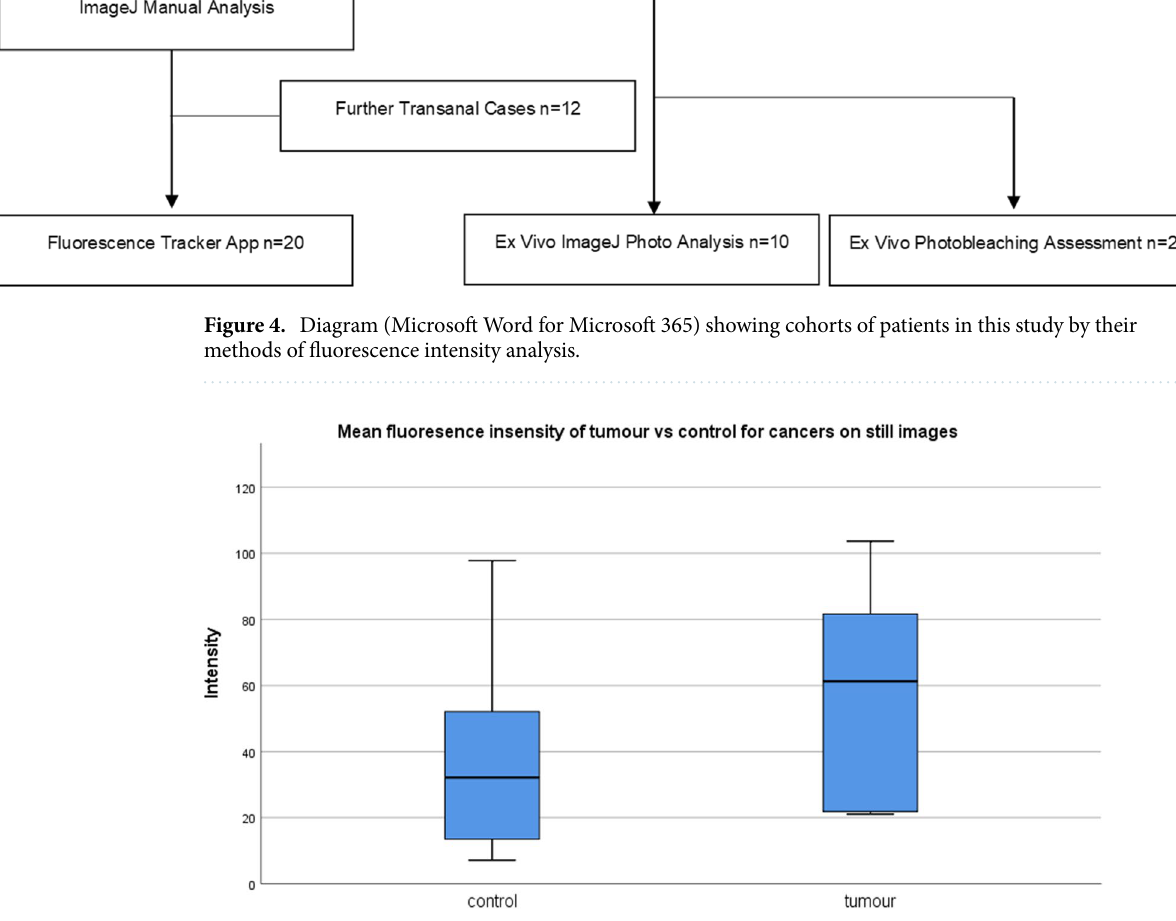
Figure 5. Box plots (SPSS Software version 26) of mean fluorescence mucosal intensity measurements for cancers vs control tissue on postoperative, ex vivo, opened resection specimens via still image analysis with ImageJ in patients receiving ICG at operation